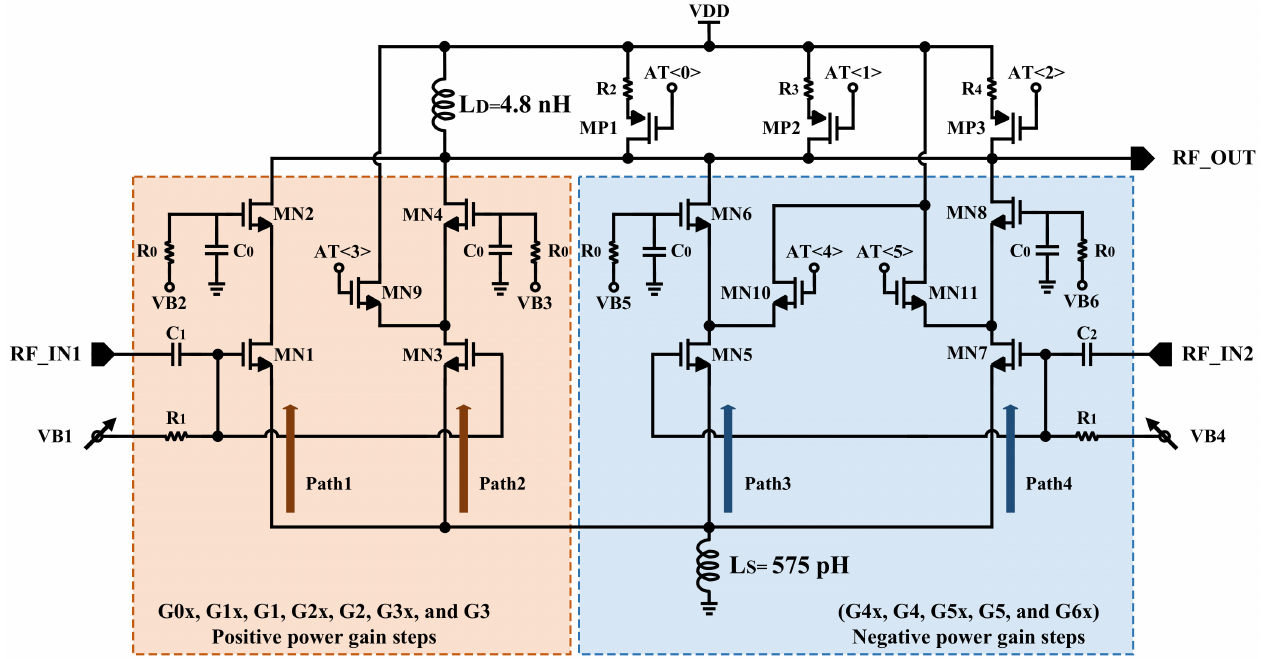
Figure 5. Multi-core structure common-source input stage with shared source degeneration